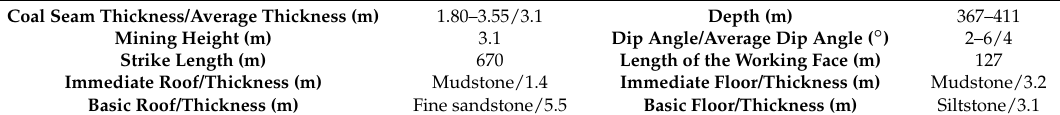
Table 1. Basic parameters of the 8304 working face in the Tashan Coal Mine.